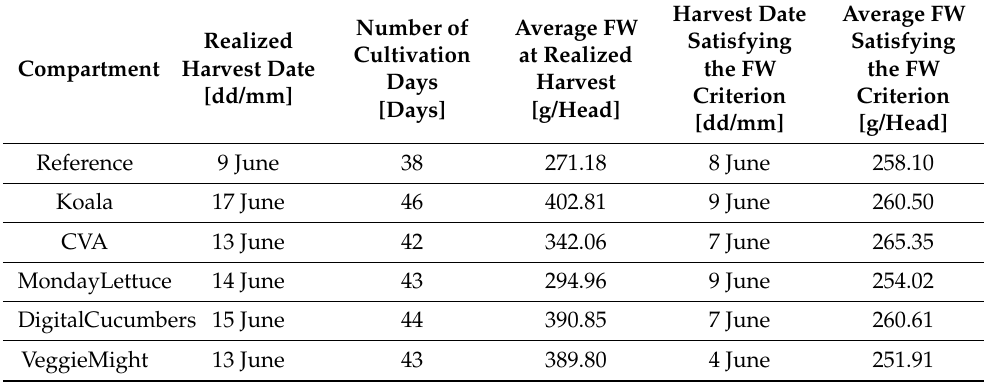
Table A3. Realized harvest dates and fresh weight at the moment of harvest along with the dates at which the weight target was realized by interpolating linearly the weekly destructive measured data.